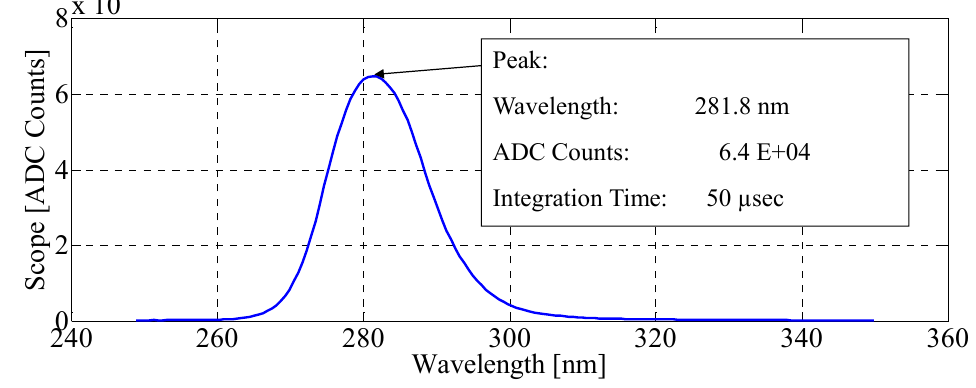
Figure 3. Measured spectrum of OPTAN280J UVC-LED from 250 to 350 nm in ADC (analogue to digital converted) counts.